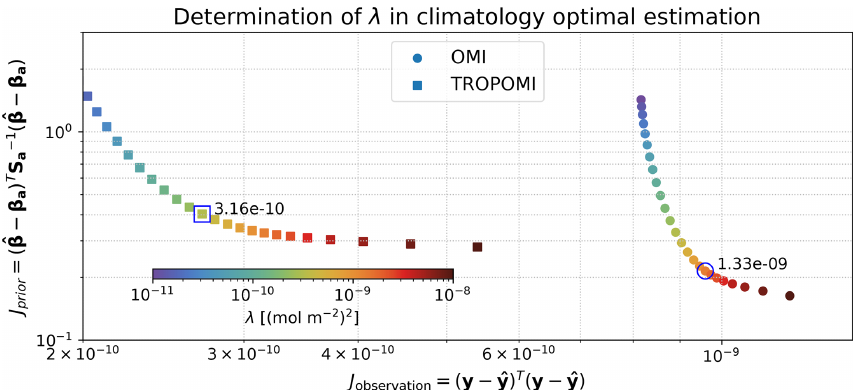
Figure B1. L-curve plot of the squared errors of a regularized solution vs. squared residuals for the climatology of OMI (dots) and TROPOMI (squares).